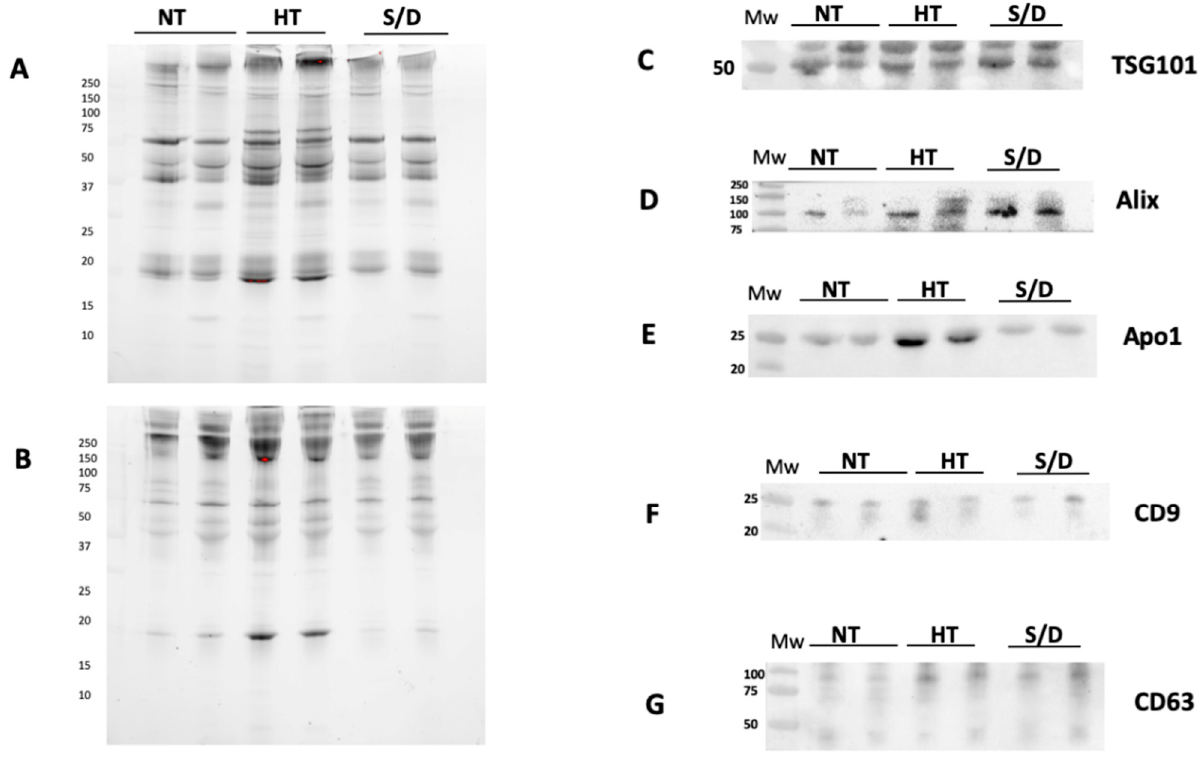
Figure 2. Western Blotting analysis of EVs isolated by ultracentrifugation (UC) from untreated (NT), heat-treated (HT) and solvent/detergent (S/D)-treated healthy sera. N = 12. The SDS PAGE of pellets was run in non-reducing conditions ( A ) and reducing conditions ( B ). Immunoblotting was performed for TSG101 ( C ); Alix ( D ); contaminant Apoliprotein AI ( E ); tetraspanin CD9 ( F ) and CD63 ( G ).